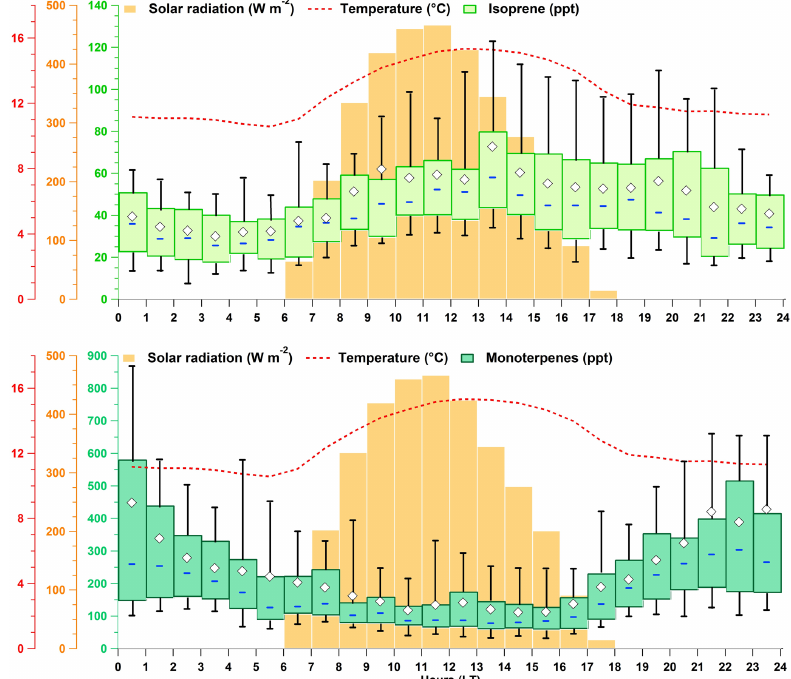
Figure 4. Diel variation of isoprene and monoterpenes, represented by hourly box plots (in green colors) in comparison to mean diel variation of meteorological parameters (solar radiation, temperature displayed as red lines and orange boxes, respectively). This figure includes all BVOC measurement days with a PTR-MS (i.e., from 1 to 29 March 2015). The white markers represent the mean value, blue solid lines represent the median values, and the green boxes show the interquartile range (IQR). The bottom and the top of box depict the first and the third quartiles (i.e., Q1 and Q3). The ends of the whiskers correspond to the first and the ninth deciles (i.e., D1 and D9). Time is given in local time (UTC +